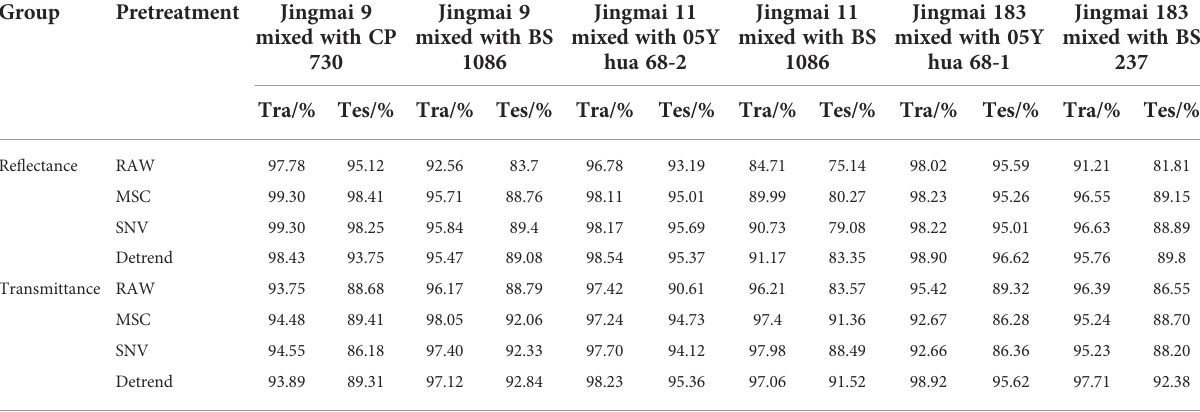
TABLE 1 The classi fi cation results based on full spectrum using PLS-DA algorithm. Group